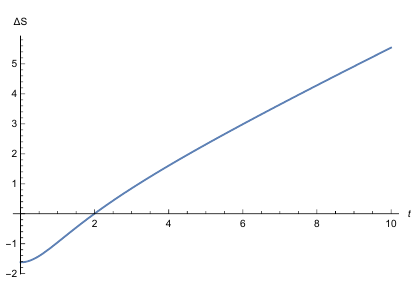
Figure 12 : Time dependence of ∆ S for the half-plane subregion. The numerical values = 1 , A = 1 have been α H